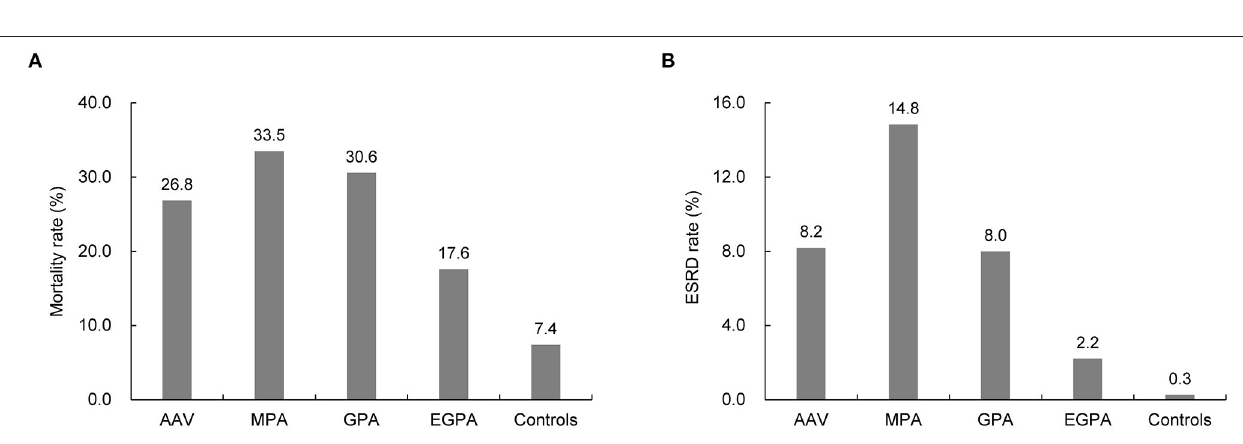
FIGURE 4 | Comparison of mortality and ESRD rate between patients with ANCA-associated vasculitis and controls. Compared to the controls, patients with AAV had higher rates of (A) mortality and (B) developing ESRD. ESRD, end-stage renal disease; ANCA, antineutrophil cytoplasmic antibody; MPA, microscopic polyangiitis; GPA, granulomatosis with polyangiitis; EGPA, eosinophilic granulomatosis with